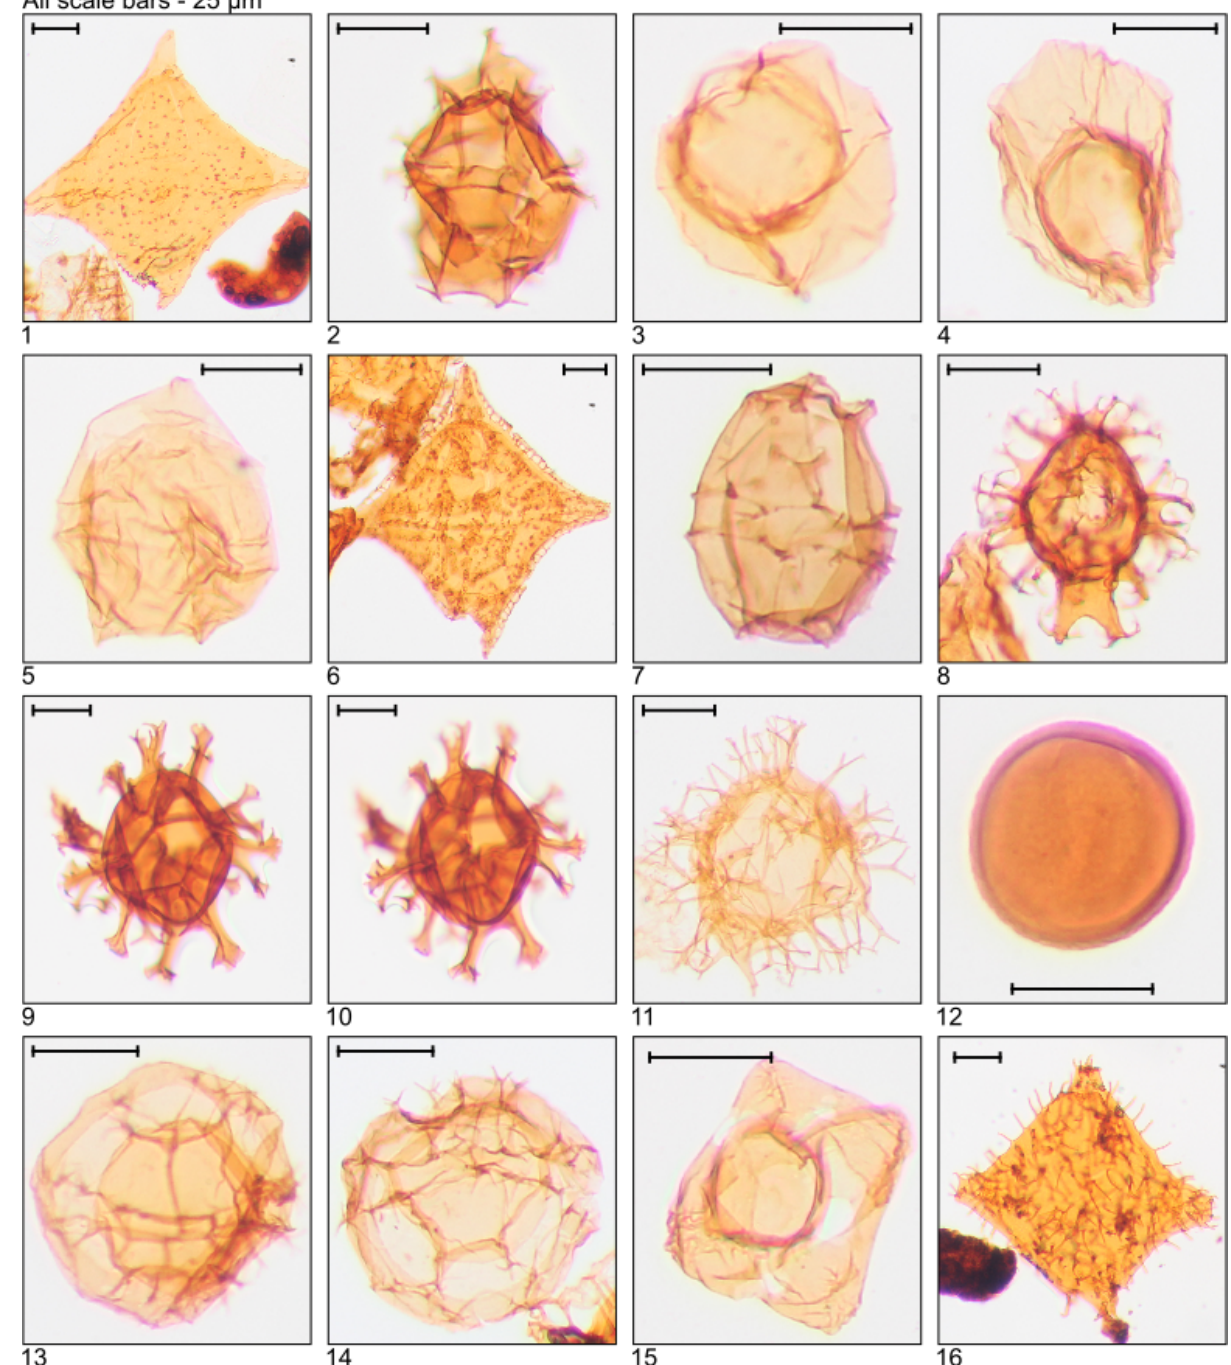
Plate 5. Illustration of taxa and sample or slide number. (1) Rhombodinium spinula (MG447; 136.3m; C21). (2) Rottnestia borussica (MG459; 139.9m; C13-1). (3, 4) Saturnodinium pansum (MG311; 94.8m; T8-4; MG411; 125.3 m; C9-4). (5) Senegalinium sp. (MG55; 16.8m; C15). (6) Sophismatia tenuivirgula (MG55; 16.8m; E9-3). (7) Spiniferites bentorii (MG55; 16.8m; G18-1). (8) Spiniferites mirabilis (MG259; 78.9m; H11). (9, 10) Spiniferites pseudofurcatus (MG459; 139.9m; E7-2). (11) Spiniferites ramosus group (MG59; 18.0m; E10). (12) Tectatodinium pellitum (MG59; 18.0m; H9-1). (13, 14) Thalassiphora spinifera (MG463; 141.1m; C9; MG363; 110.3m; C20). (15) Turnhosphaera hypoflata (MG343; 104.6m; E22). (16) Wetzeliella articulata (MG319; 97.2m;